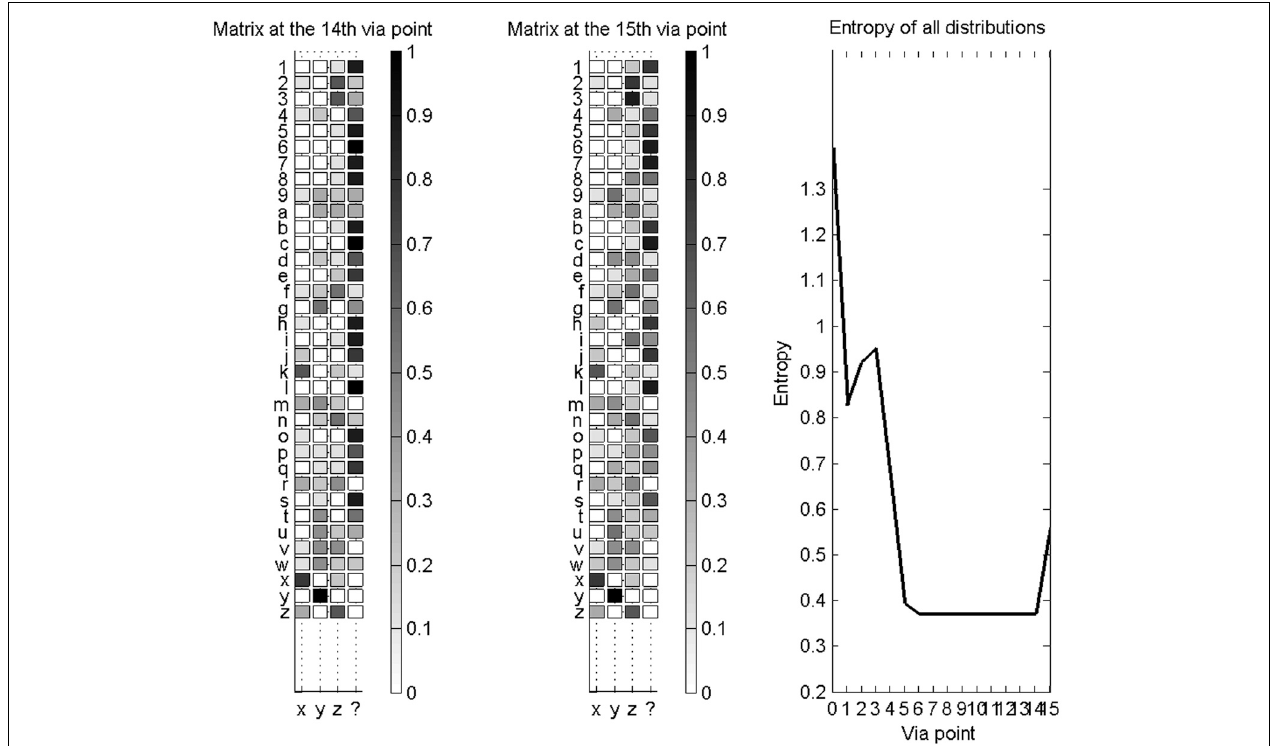
FIGURE 13 | Novelty detection for a database of known characters restricted to “x,” “y,” “z,” and the unknown character “$”. Left : confusion matrix for the recognition of all available characters, after the collection of 14 via-points. Middle : confusion matrix for the recognition of all available characters, after the collection of 15 via-points and